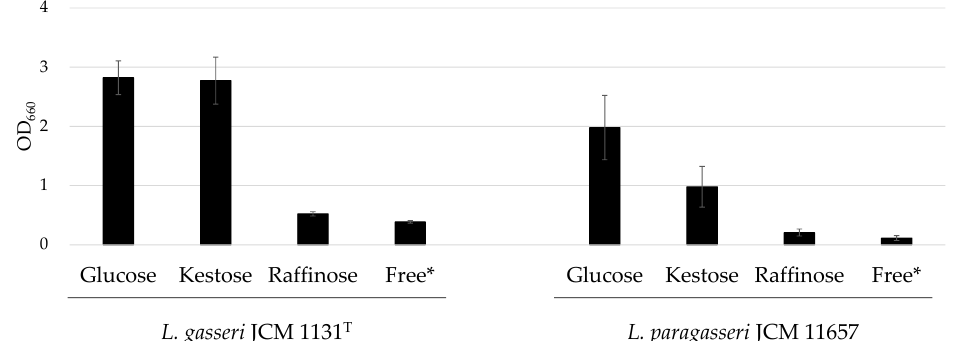
Figure 1. Growth characteristics of L. gasseri JCM 1131 T and L. paragasseri JCM 11657 cultured in the presence of glucose, kestose, or raffinose. Bars show averaged cell growth expressed as optical density at 660 nm (OD 660 nm ), and error bars indicate standard deviations (n = 3). * Sugar-free medium.